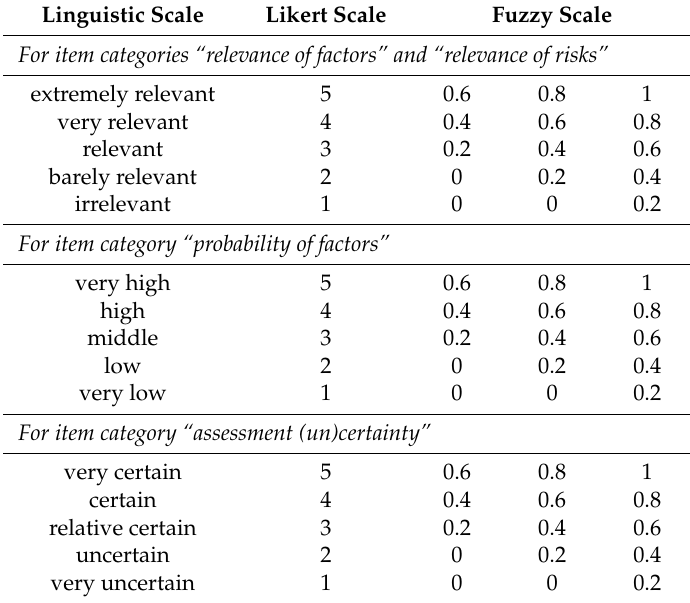
Table A2. Linguistic variables of Delphi survey item-categories and corresponding Likert and fuzzy scales.